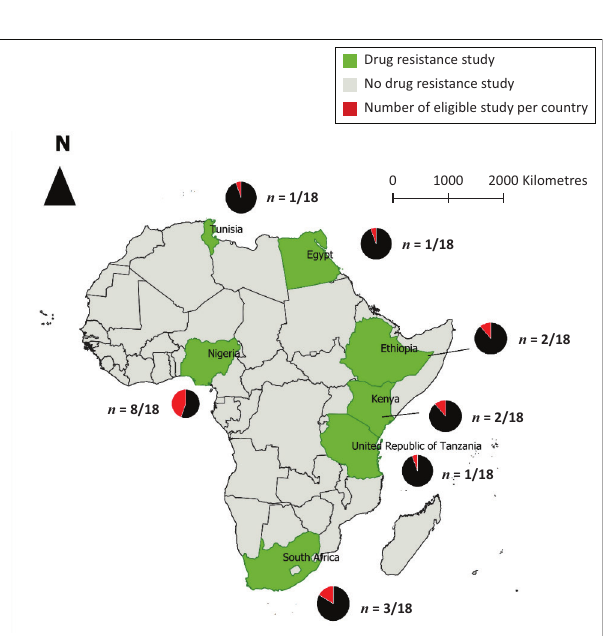
FIGURE 2: Map of countries where antibiotic resistance is studied amongst